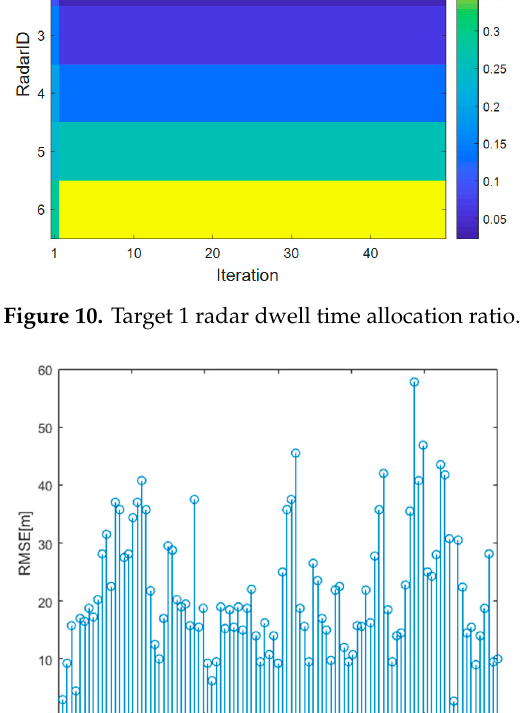
Figure 11. RMSE for target tracking.